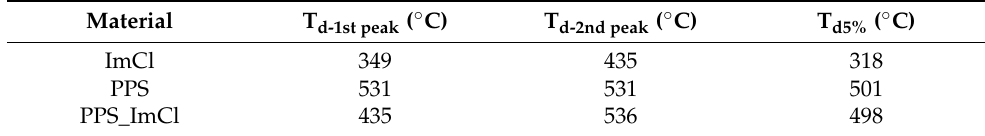
Table 2. Thermal stability of neat PPS, PPS_ImCl and ImCl.